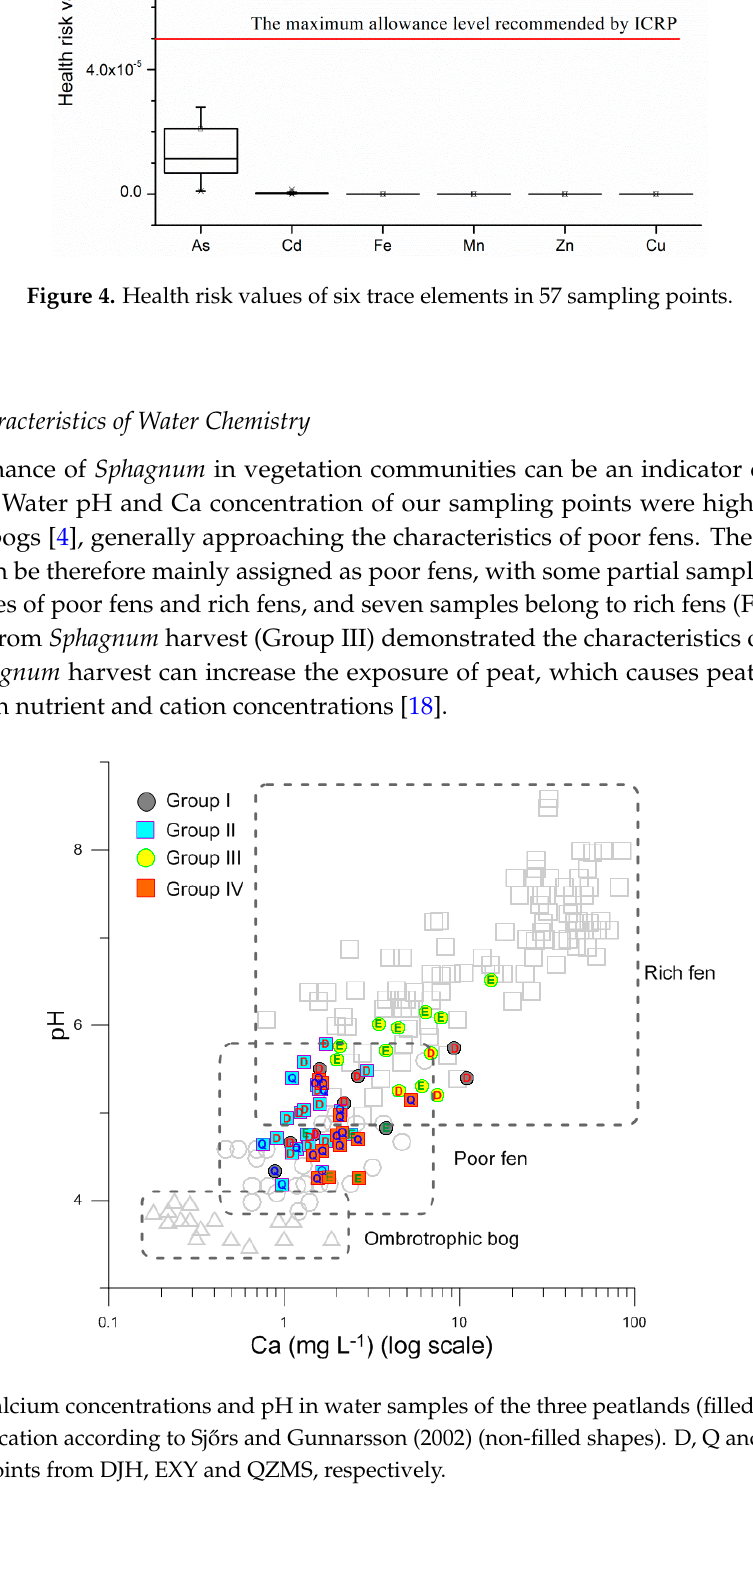
0.16 Figure 3. ( A ) Principal component analysis (PCA) ordination diagram of samples based on environmental parameters; ( B ) cluster analysis of samples using the method of Ward’s minimum variance. The color code represents samples from DJH (D), QZMS (Q), and EXY (E), and the symbol code in ( A ) represents the four groups. In total, the mean health risk value of the six elements was 3.5 × 10 − 6 a − 1 , indicating a low health risk in these peatlands (for details, see Supplementary Table S3). Based on the mean health risk